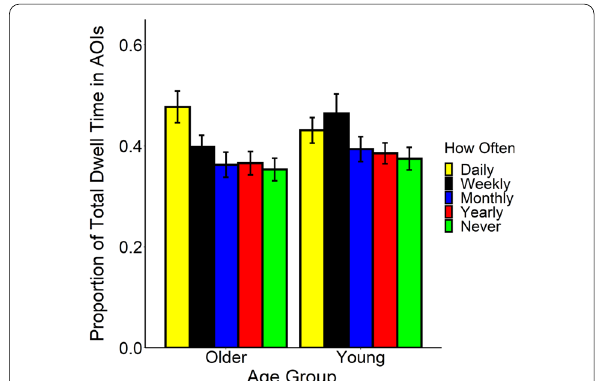
Fig. 4 Proportion of total dwell time spent in the goal-relevant areas of interest. Participants dwelled more in the goal-relevant regions when they performed the activity daily than if they performed the activity monthly, yearly, or never. Error bars represent 1 standard error around the estimated